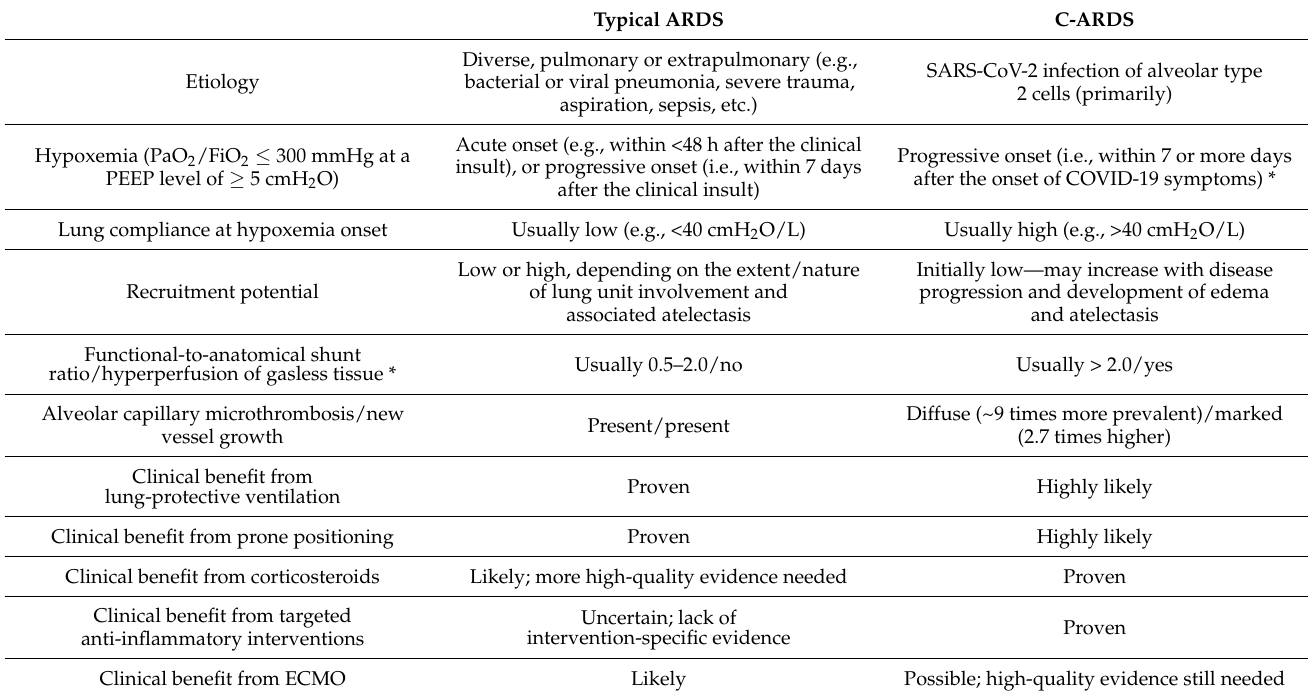
Table 2. Comparative presentation of major characteristic features of typical ARDS and C-ARDS. ARDS , acute respiratory distress syndrome; C-ARDS , coronavirus disease (COVID) 19-related ARDS; SARS-CoV-2 , severe acute, respiratory syndrome coronavirus 2; PaO 2 /FiO 2 , oxygen arterial partial pressure-to-fraction of inspired oxygen fraction ratio; PEEP , positive end-expiratory pressure; ECMO